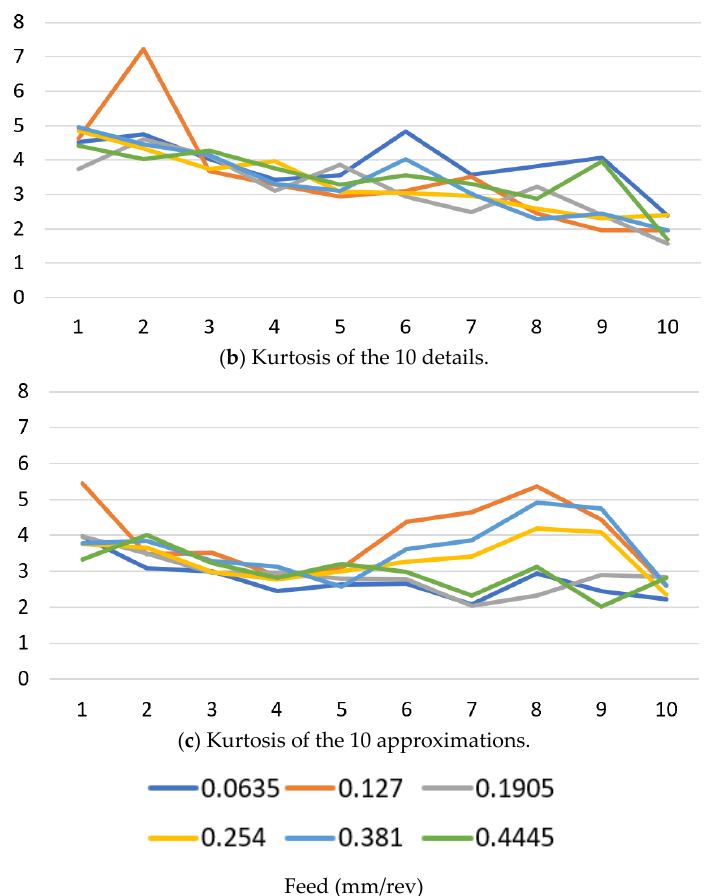
Figure 5. Sample results for 10 wavelet approximation and details at 400 rpm and 1.22 mm D.O.C.